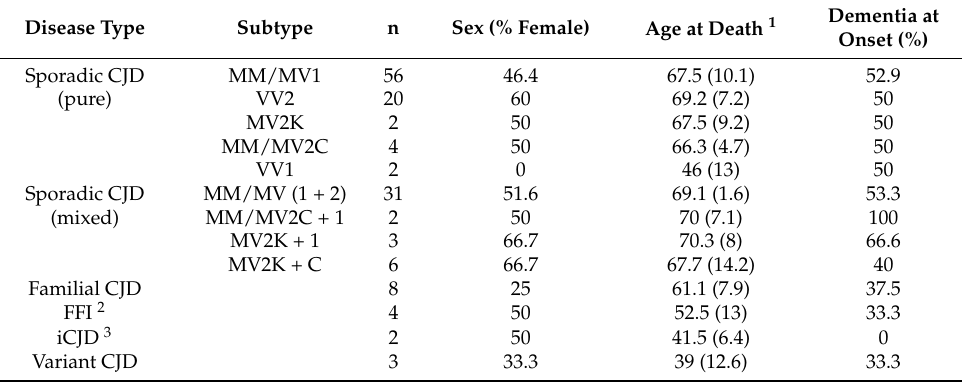
Table 1. Distribution of human prion disease cases between diagnostic entities including some basic sociodemographic and clinical data. Pure and mixed sCJD cases are classified in separate groups. Disease